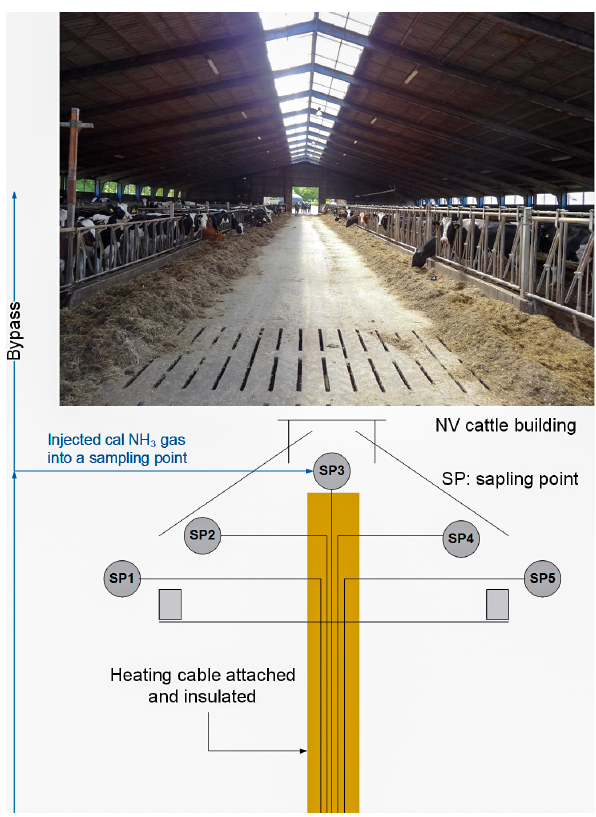
Figure A1. Schematic of the sampling point inside the cattle build- ing. SP1 and SP5 were placed outside for background measurement at 2.5m height. SP2 and SP4 were on the walls at 2.5m height. SP3 was placed below the ridge at 9m height. The lines were approx- imately 5, 15, 35, 45 and 50m for SP1, SP2, SP3, SP4 and SP5,